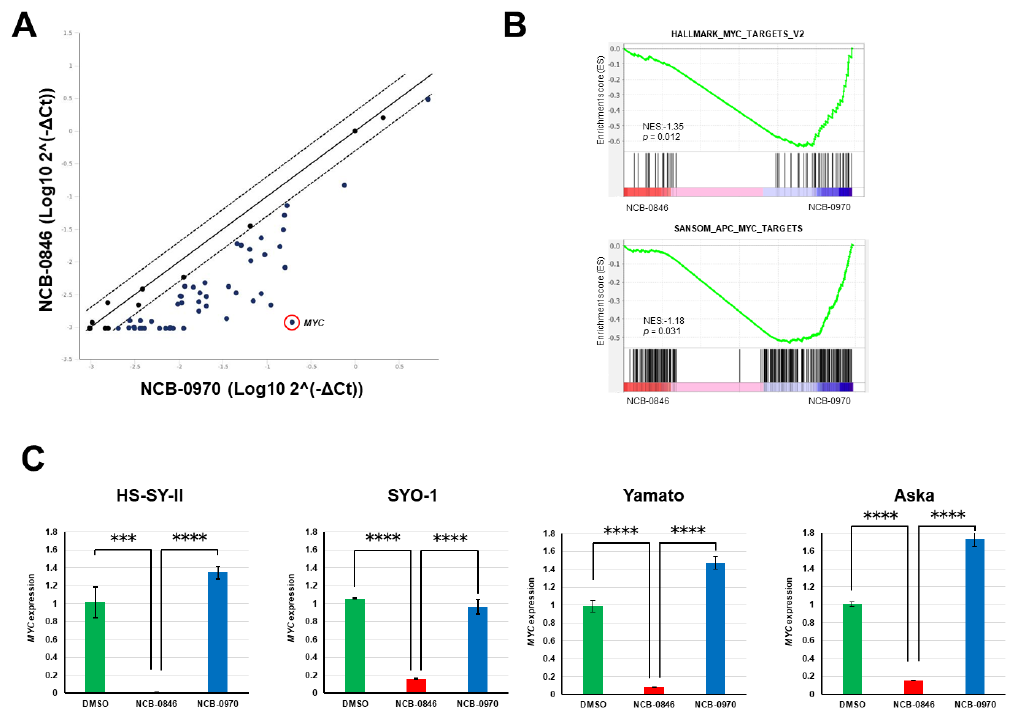
Figure 5. NCB-0846 suppresses MYC gene expression. ( A ) Comparison of Wnt target gene expression (normalized to GAPDH and log-transformed) of HS-SY-II cells treated with NC-0846 and NCB-0970 for 6 h. ( B ) Significant enrichment of c-MYC target genes revealed by RNA sequencing and Gene set enrichment analysis (GSEA). ( C ) Four synovial sarcoma cell lines were treated with dimethyl sulfoxide (DMSO) (control), NCB-0846 (3 µM), or NCB-0970 (3 µM) for 6 h, and expression of the MYC gene (relative to DMSO) was quantified by real-time RT-PCR and normalized to that of ACTB . *** p < 0.0005, **** p < 0.0005 (multiple t -test corrected using the Holm–Sidak method). Data represent the mean ± S.D. of three